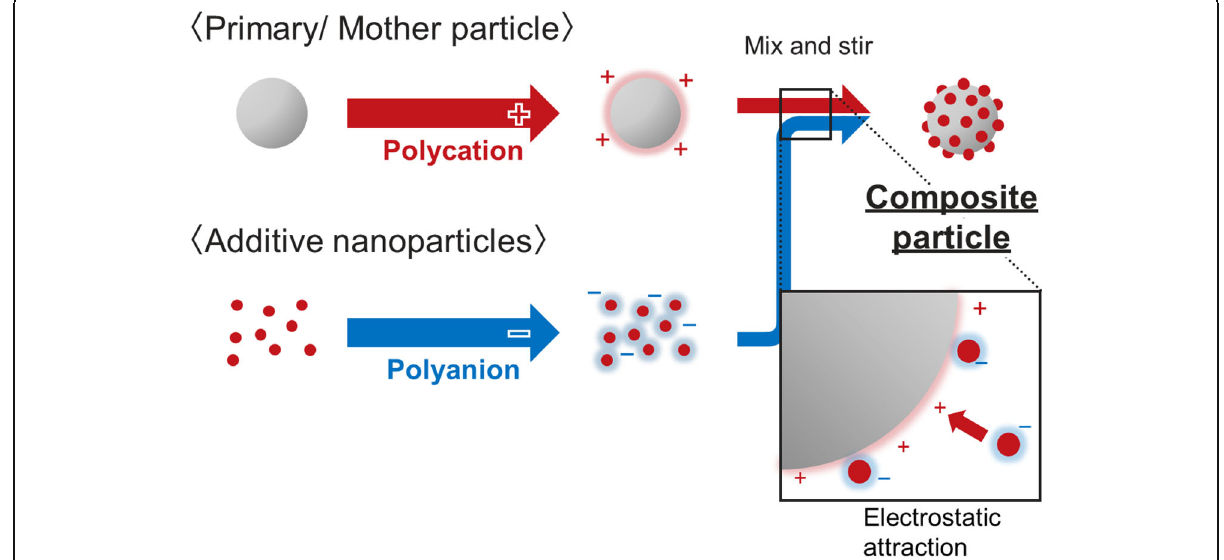
Fig. 2 Schematic of surface electrostatic charge adjustment using polycation and polyanion for the formation composite